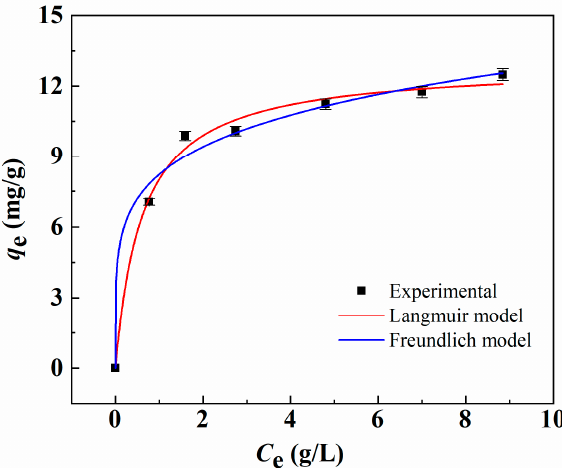
Figure 7. The adsorption isotherm curves for Li + onto MCM- g -AB15C in acetonitrile fitting with di ff erent models.